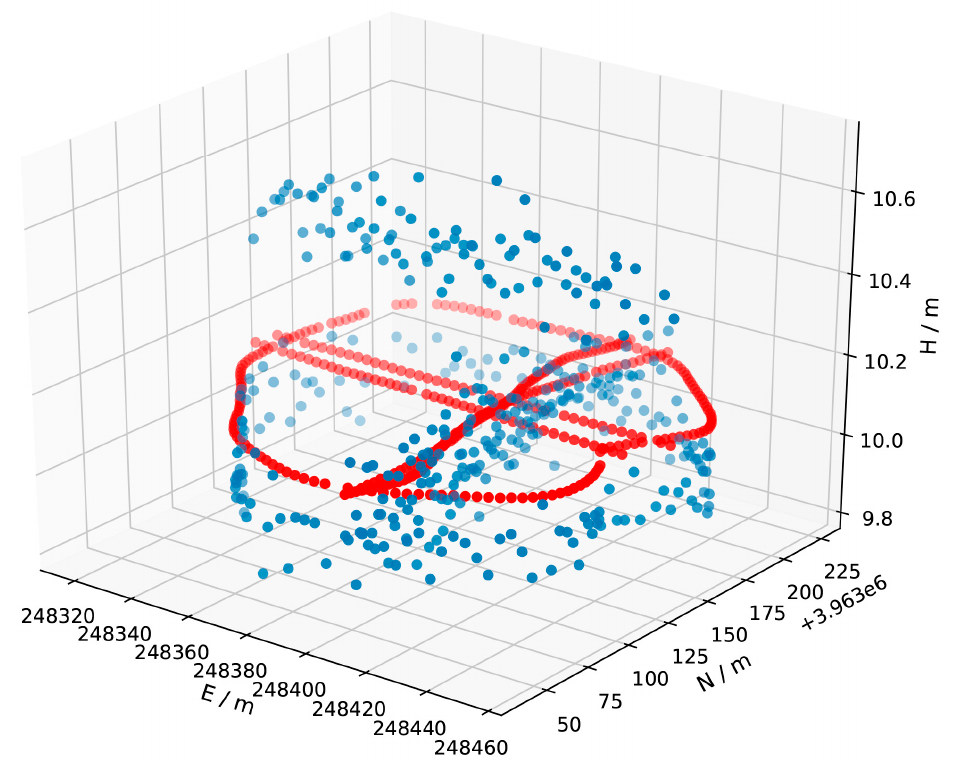
Figure 2. The section of the ship’s 3-D sailing track diagram (the blue points, which are scattered and do not display the regular geometry, denote the 3-D track position of the ship; the red points, which present clearly circle and cross tracks, are the projections of blue points to the average height plane; the depth of the dot colour represents the distance from the perspective).